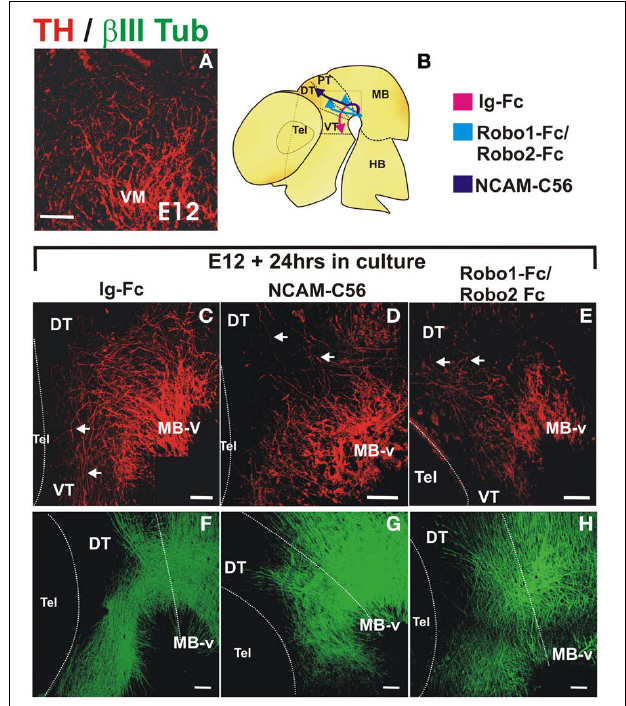
FIGURE 7 | NCAM and Robo1/2 ectodomains impair projection of midbrain dopaminergic axons in whole embryo culture. Whole E12 rat embryos were cultured for 24h in control medium (C,F) or in medium with either NCAM or Robo1/Robo2 soluble ectodomains (D,G , E,H , respectively ) followed by TH (red) or β III-Tubulin (green) immunostaining. Flat-mounted hemibrains are shown. (A) Shows TH signal in a normal E12 embryo at the beginning of the culture. (C–F) Show control growth and (D,G,E,H) show halted growth or misprojection in cultures with NCAM or Robo1/2 ectodomains, respectively. The diagram in (B) shows the growth observed in each condition. Arrows in (C) indicate normal growth of TH axons into the diencephalon and in (D,E) indicate aberrant dorsally projecting axons. Scale bar: 100 μ m. on slides coated with fibronectin (FNIII) or on slides coated additionally with the NCAM or Robo1/Robo2